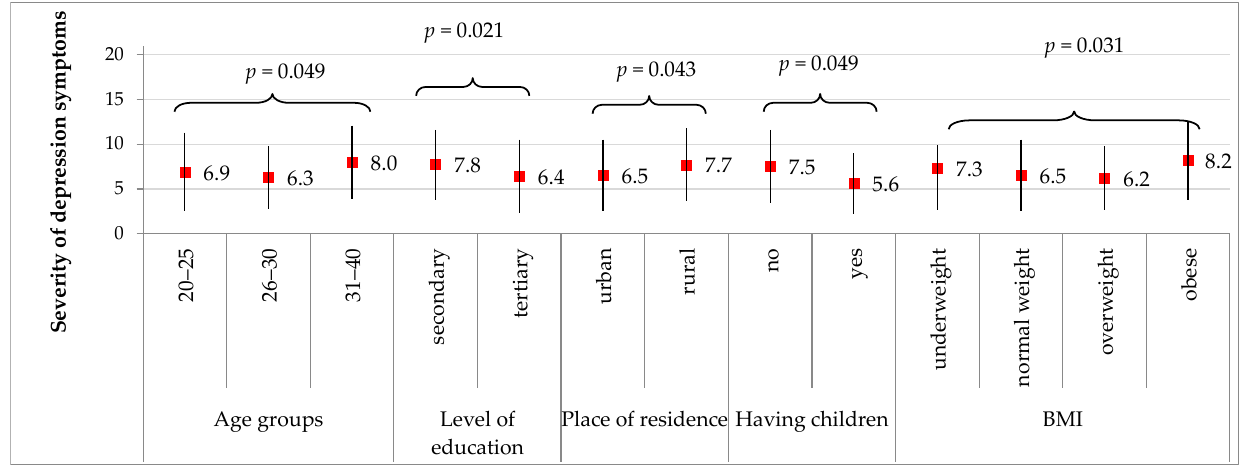
Figure 5. Significant correlations for the severity of depression symptoms acc. to HADS with socio- demographic characteristics in the PCOS group. Results are presented as mean ± standard devia- tion. p for Student’s t test or F test of analysis of variance. In the PCOS group, severity of depression symptoms did not correlate with p for Student’s t test for level of education, place of residence, marital status, and having had children. p for F test analysis of variance for age groups, BMI groups.